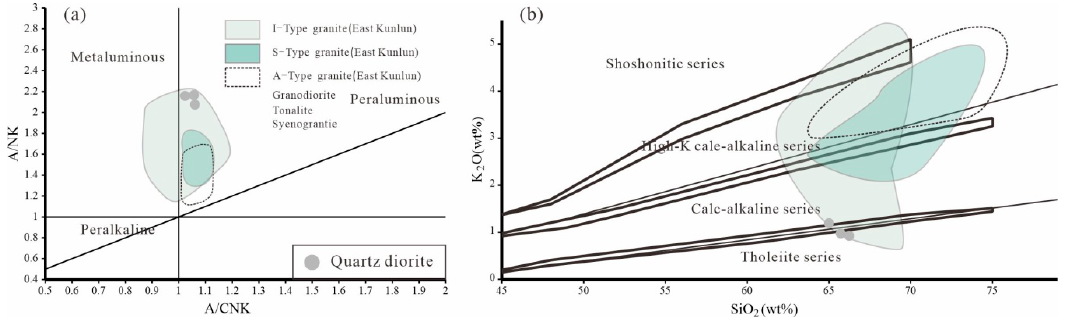
Figure 8. A/CNK-A/NK ( a ) and SiO 2 -K 2 O ( b ) diagrams for the Gayahedonggou quartz diorite. The fields are similar magmatic rocks in the EKOB (these data come from geological maps (1:50,000, 1:250,000)). Figure 8a is modified from [57]; Figure 8b is modified from [58,59].